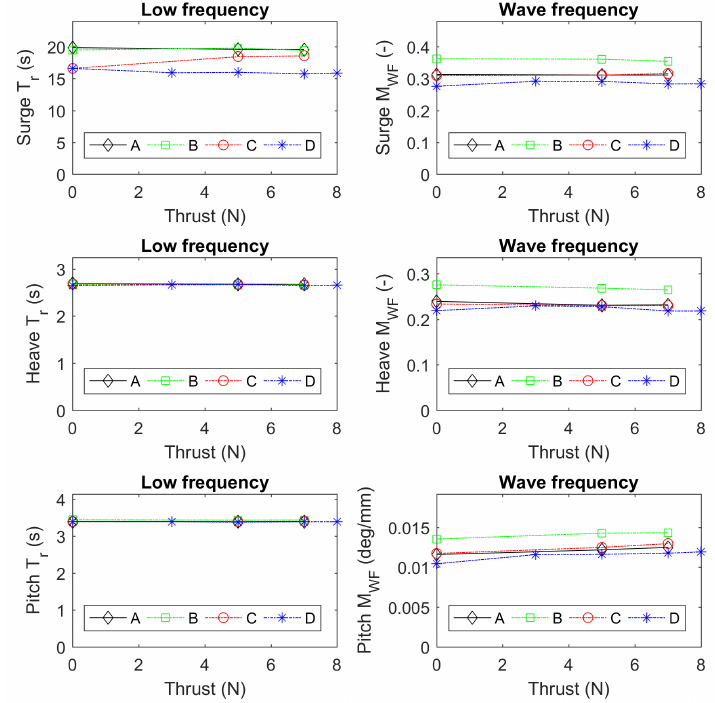
Figure 21. Metrics T r (left column) and M WF (right column) for JONSWAP T p = 1.29 s, H s = 5 cm per facility for surge (top row), heave (middle row), and pitch (bottom row) at thrust levels of 0, 3, 5, 7, and 8 N (8 N applied at facility D